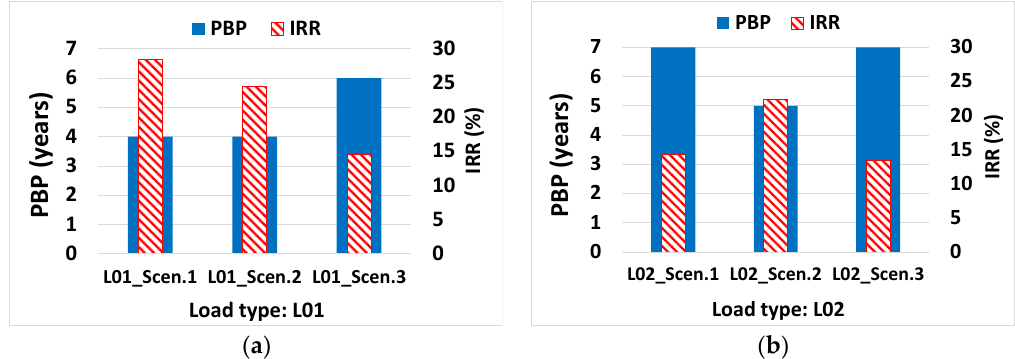
Figure 16. Payback period (PBP) and internal rate of return (IRR) for the scenarios and the two-load types; L01 ( a ); L02 ( b ).